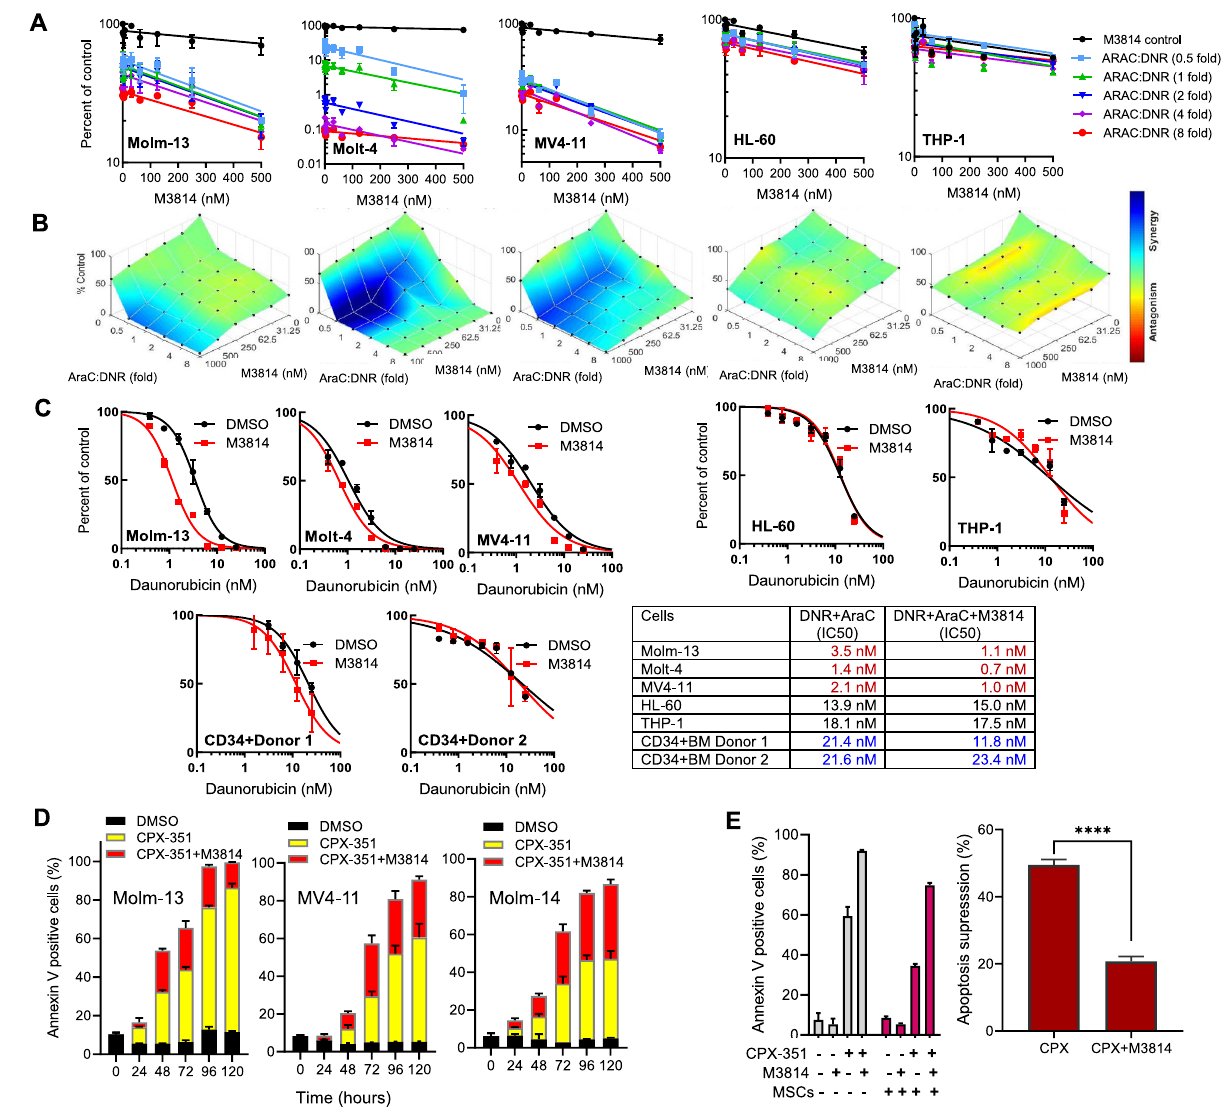
Figure 6. M3814 enhances the effect of DNR/AraC combination therapy in acute leukemia cells. ( A ) Molm-13, Molt-4, MV4-1, THP-1 and HL-60 cells were pre-treated with the indicated concentrations of M3814 or vehicle for 45 min before the addition of 1 nM DNR and increasing concentrations of Ara-C at AraC:DNR ratios: 0.5, 1, 2, 4 and 8. Cell viability was assessed by the CellTiter-Glo assay on D 4. ( B ) Combination activity in the above treatment was assessed by the Bliss synergy method using Combenefit software. ( C ) Molm-13, Molt-4, MV4-11, THP-1, HL-60 and BM CD34 + cells isolated from two independent healthy donors were pre-treated with M3814 (300 nM) for 45 min followed by addition of increasing DNR concentrations in combination with a fixed dose of Ara-C (50 nM). Cell viability was assessed on day 3 by the CellTiter-Glo assay. IC50 values were calculated using GraphPad Prism. Representative data from three independent experiments is shown. ( D ) MOLM-13, MV4-11 and MOLM-14 cells were treated with CPX-351 (62.5 nM) with or without M3814 (500 nM) for indicated treatment times. Percentages of annexin V positive cells were determined by flow-cytometry and plotted as stacked bars. ( E ) Left: MOLM-13 cells were cultured with or without MSC and treated with CPX- 351 (62.5 nM) with or without M3814 (500 nM). 25,000 MSC were seeded one day before starting co-culture. Percentages of annexin V positive cells in MOLM-13 cells were determined by flow-cytometry. Right: Inhibition of apoptosis in MOLM-13 cells co-cultured with MSC and treated with CPX-351 with or without M3814. **** p <